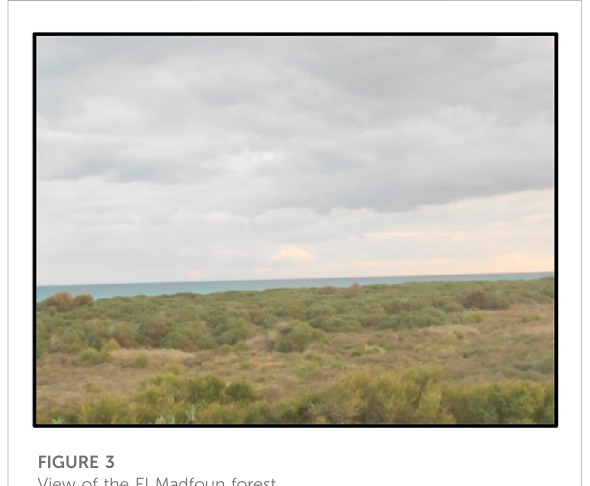
FIGURE 4 View of the Halq El Mingel sebkha.